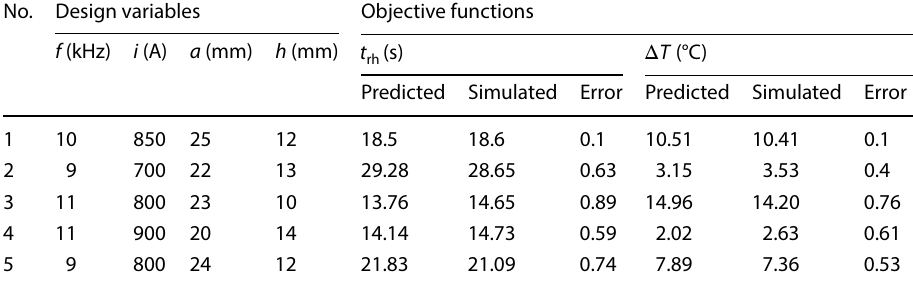
Table 4 Comparison of results obtained by the developed response surface models and numerical simulations with five random combinations of design variables in the design space